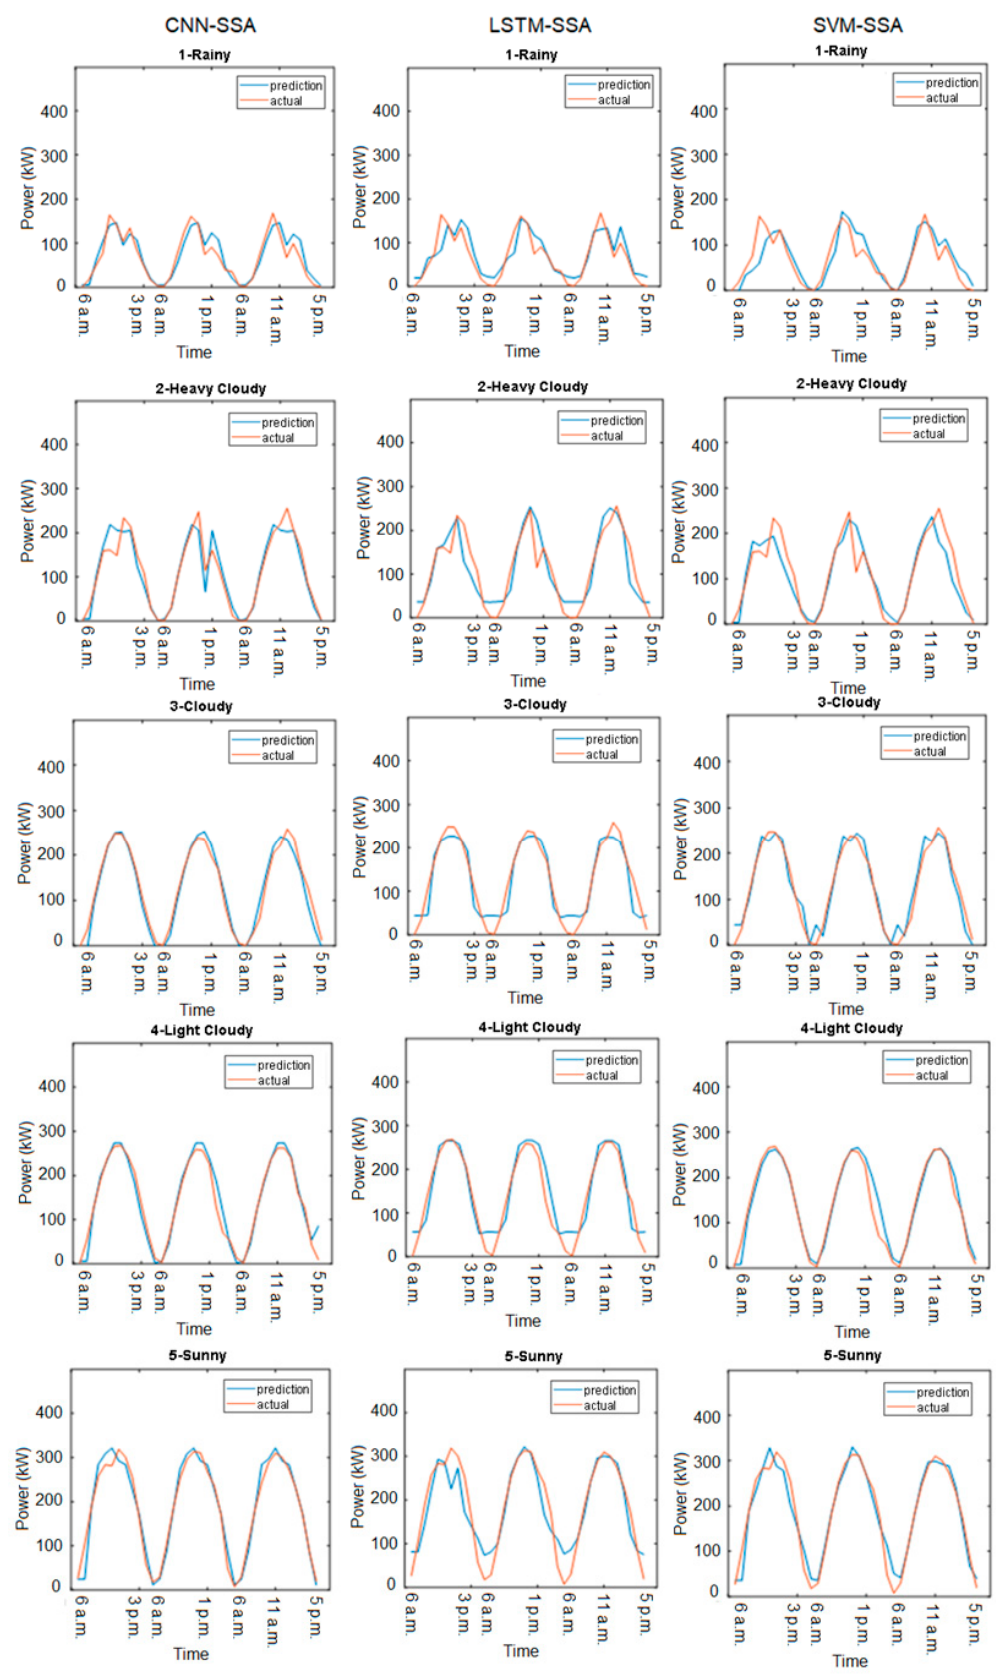
Figure 12. Forecasting results comparison with the SSA integration.